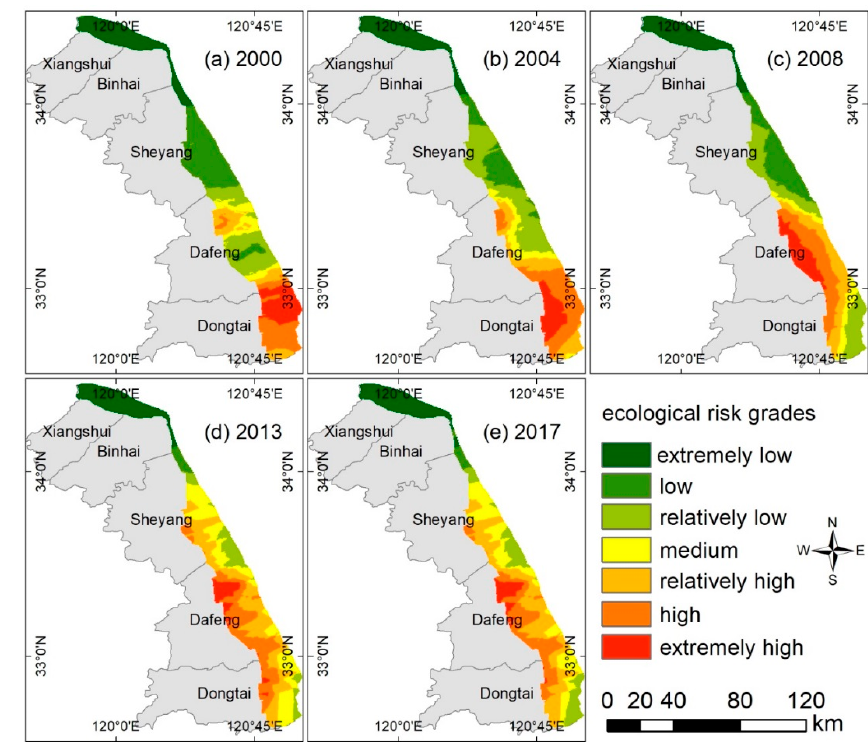
Figure 7. Evolution of the spatial distribution of ecological risk index grades of the open coastal wetlands in Jiangsu (OCWJ) during the five periods from 2000–2017. ( a ) Map of the spatial distribution of ecological risk index grades in the year 2000; ( b ) map of the spatial distribution of ecological risk index grades in the year 2004; ( c ) map of the spatial distribution of ecological risk index grades in the year 2008; ( d ) map of the spatial distribution of ecological risk index grades in the year 2013; ( e ) map of the spatial distribution of ecological risk index grades in the year 2017. Int. J. Environ. Res. Public Health 2018 , 15 , x